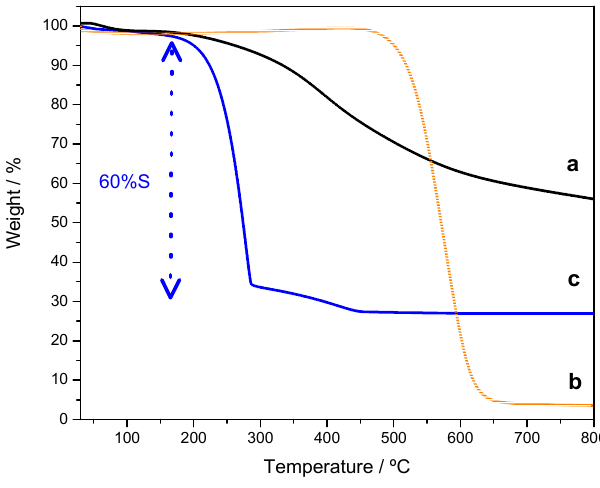
Figure 1. Thermogravimetric (TG) analysis of ( a ) AS [N 2 ], ( b ) ASC [O 2 ] and ( c ) ASC/S composite [N 2 ].